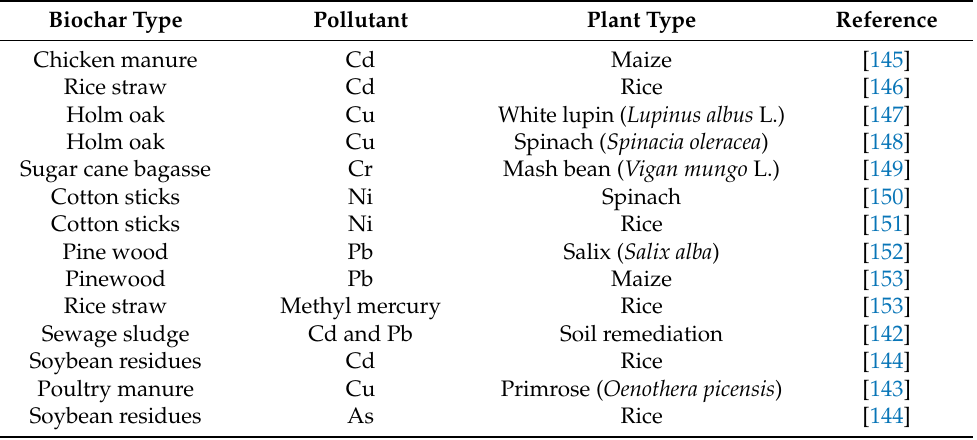
Table 3. Reduced uptake of different chemicals after biochar application into